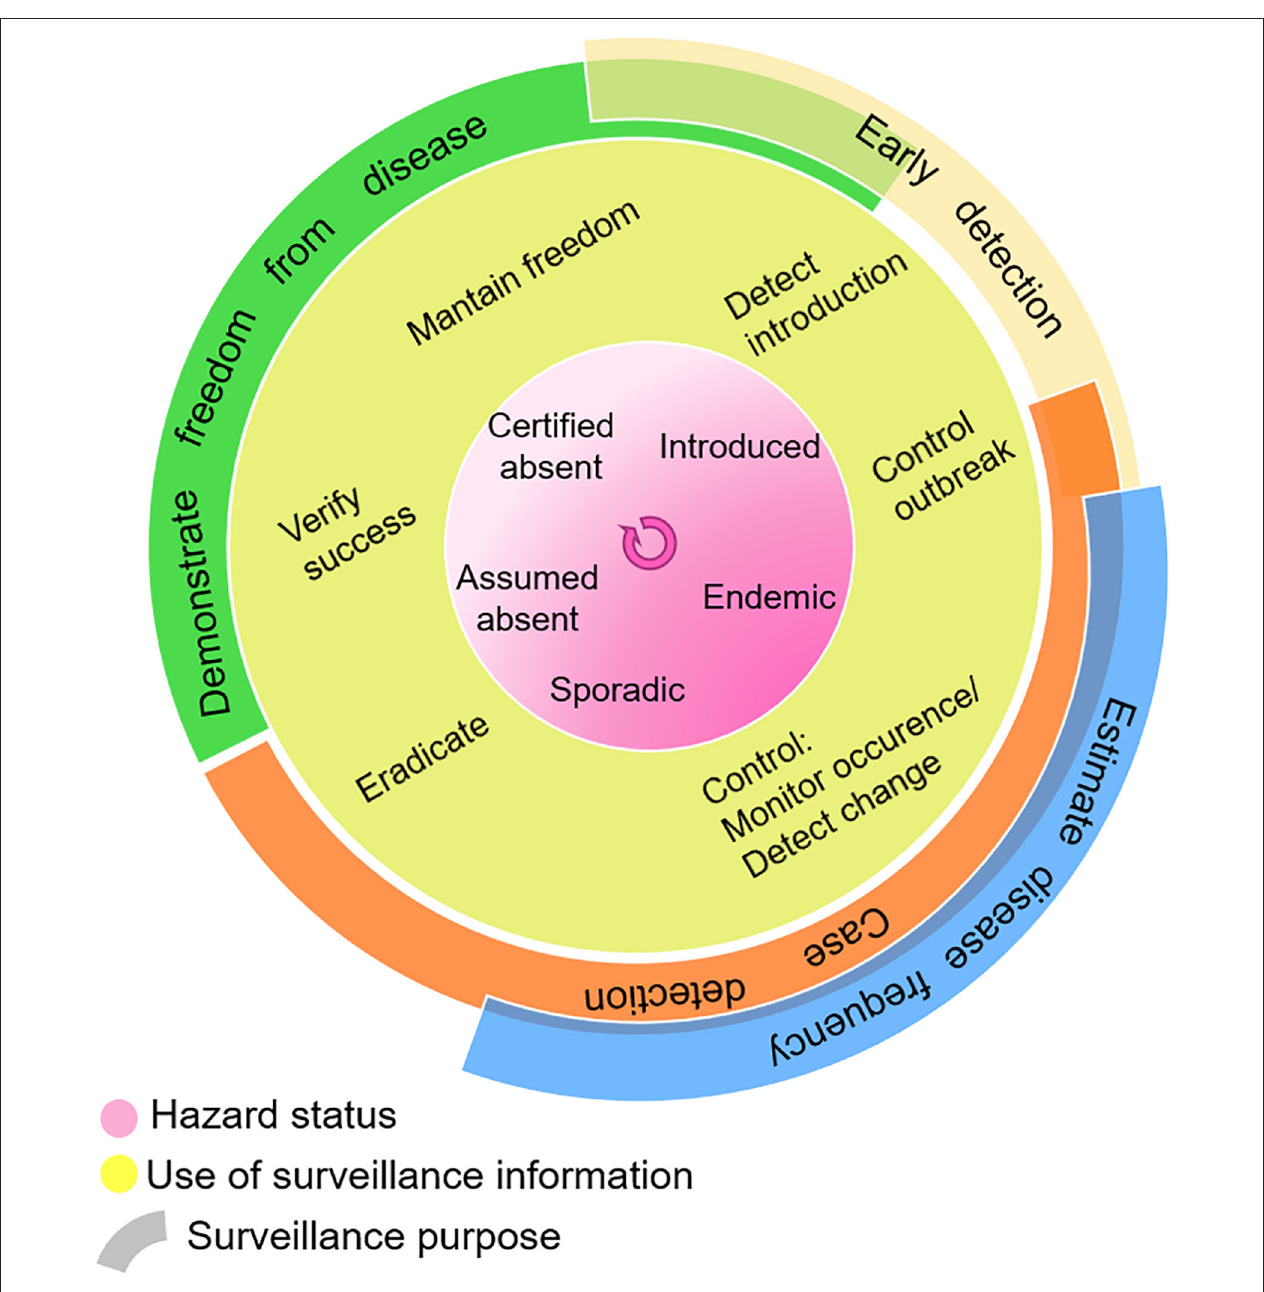
FIGURE 2 | Use of surveillance information in the context of hazard status, and surveillance purpose. Adapted with permission from Linda Hoinville (41).